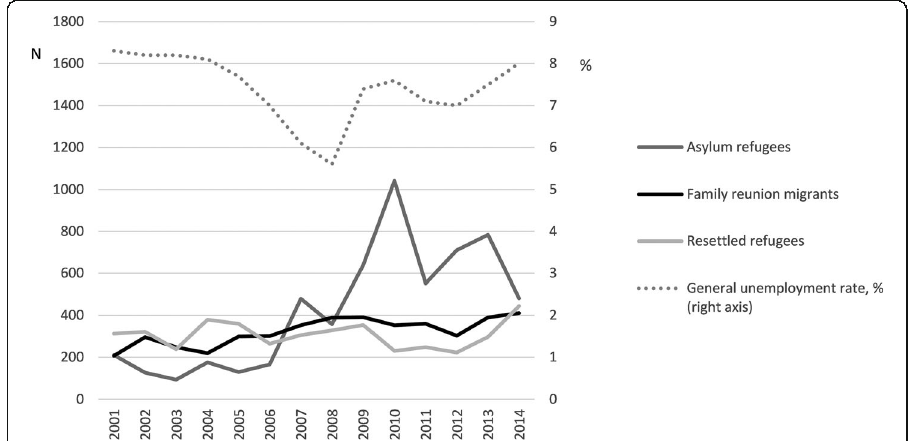
Fig. 1 The frequencies of refugee categories by migration year juxtaposed with general unemployment rate in Finland. Source: frequencies from the data and employment rate from the Labor Force